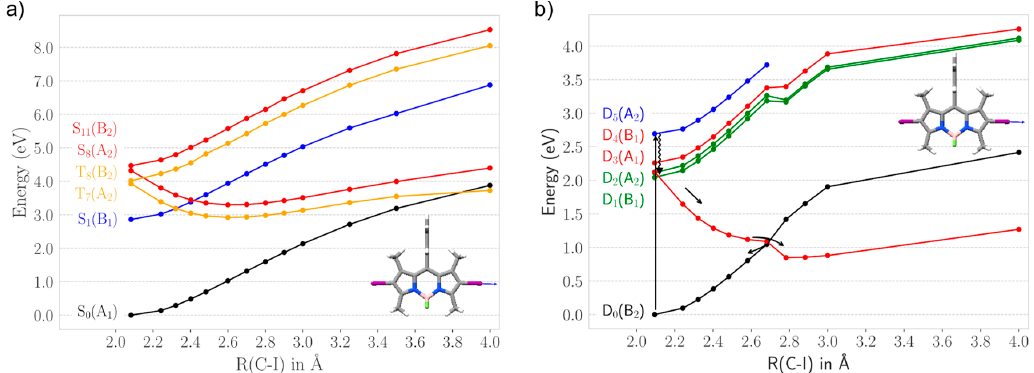
Figure 4. Relaxed TDDFT singly dissociative coordinate for the non-reduced ( a ) and reduced ( b ) dye. Arrows indicate a possible relaxation pathway starting from the bright D 5 state via IC to the dissociative D 3 state and further back to D 0 . Color code: ground state (black), bright excited singlet/doublet state (blue), dissociative singlet/doublet state (red), dissociative triplet state (orange), and CT doublet state (green).